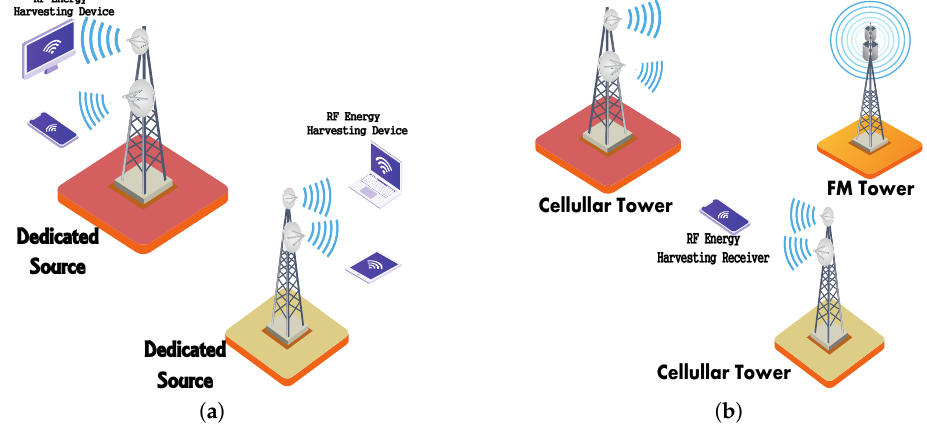
Figure 2. Illustration of dedicated and ambient energy harvesting. ( a ) Dedicated Source; ( b ) Cellular